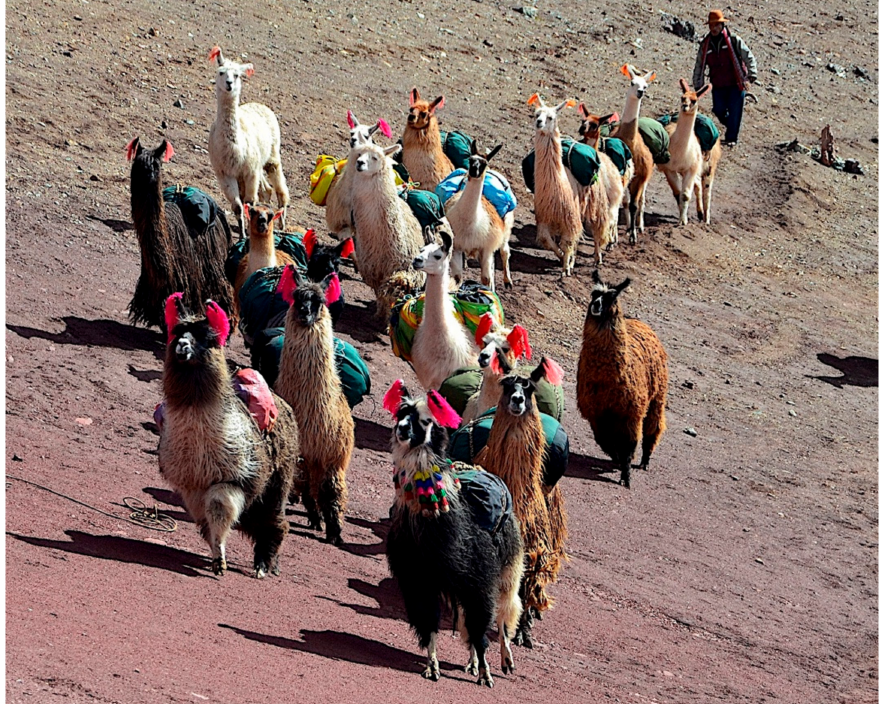
Figure 8. A high altitude Andean caravan of “llamas cargueras” used as pack animals. Note the relatively small packages transported by each animal (compared to the higher weight transporting capacity by donkeys and mules). Slightly modified from a photograph by Andean Lodges, May 2018, freely available from Wikimedia Commons under license of Creative Commons Atribuci ó n- CompartirIgual 4.0 Internacional (CC BY-SA 4.0),